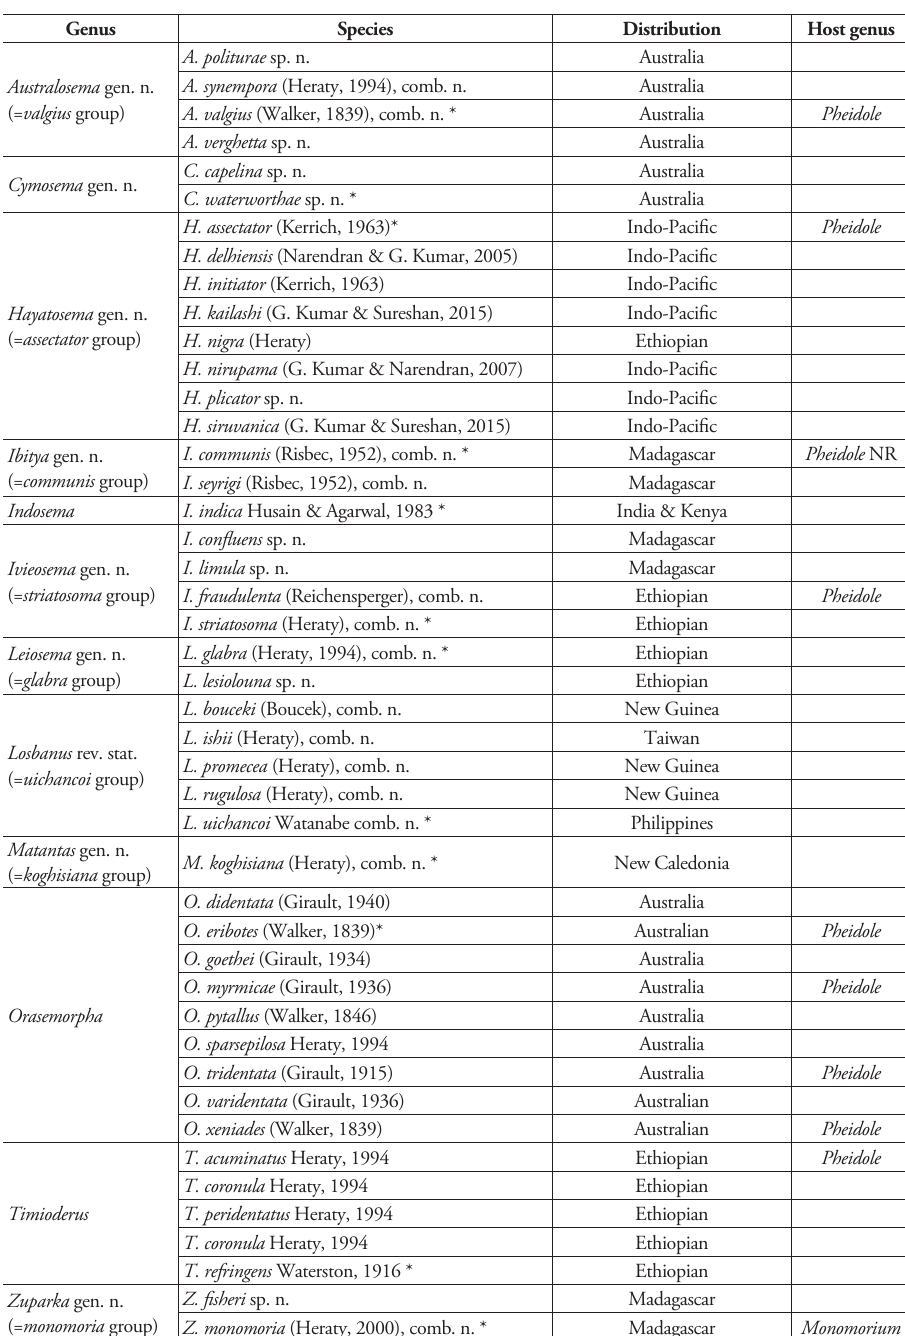
Table 1. List of Old World Oraseminae, with their geographic distribution and ant host genus. For a more complete list of synonymies and host information see Heraty (1994, 2002) and Heraty (2017). Asterisk (*) denotes type species of genus. Australian refers to Australia including Tasmania. NR is new host record.